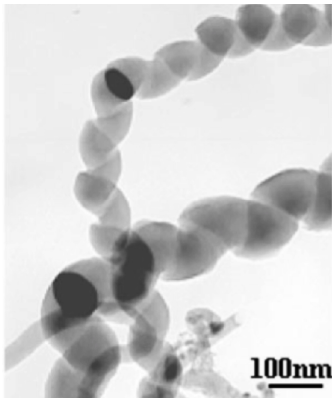
Figure 3. A growth tip of the bidirectionally grown twisted carbon filaments [23]. Reprinted with permission from [23], Copyright 2004 AIP Publishing LLC.